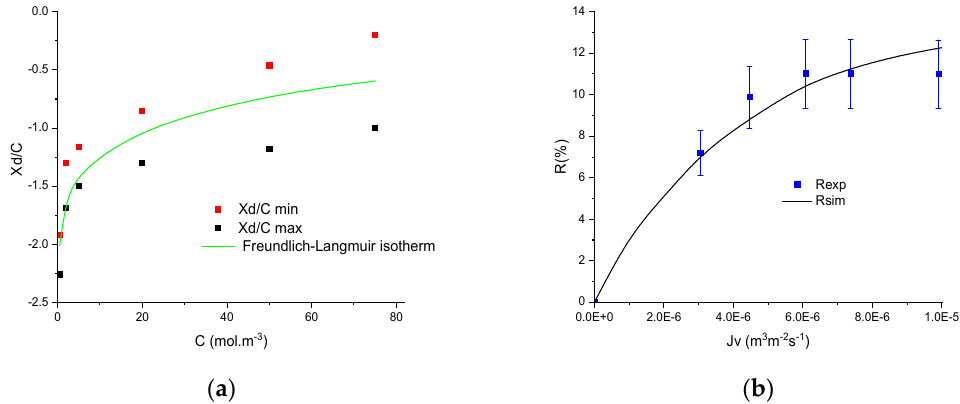
Figure 5. ( a ) Evolution of minimum and maximum normalised volumetric charge density with concentration and ( b ) rejection curve obtained experimentally and simulated from the corresponding best-fitted Langmuir–Freundlich isotherms obtained by filtration of NaI 2 mol m − 3 by the MFI–MFI membrane.